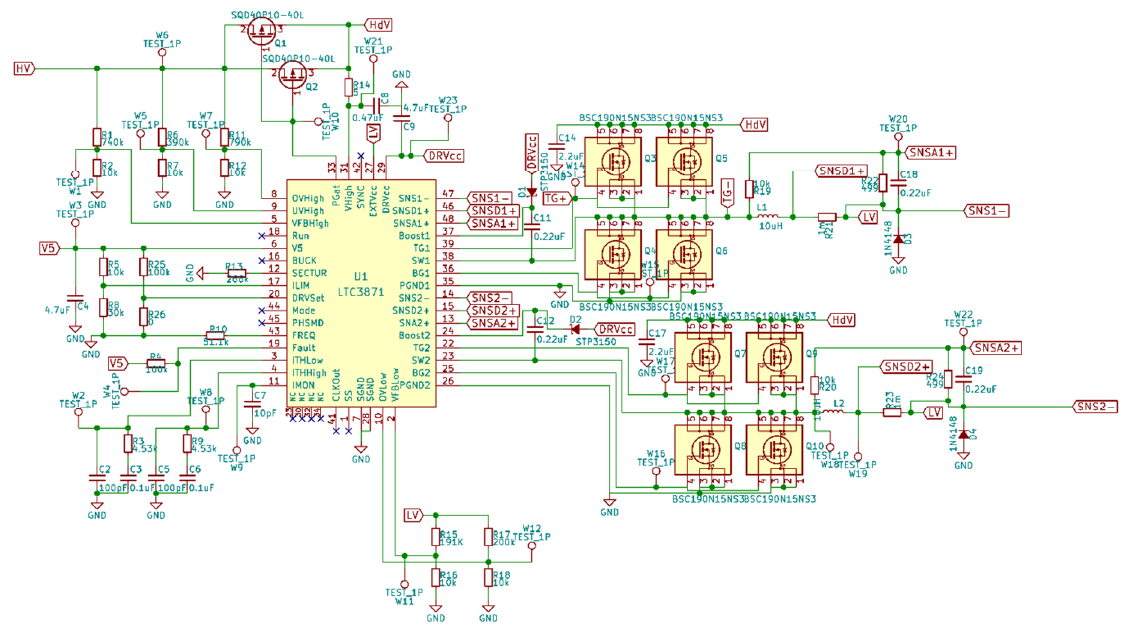
Figure A1. The schematic drawing of the DC-DC converter’s printed circuit board. “HV” labels the high voltage input; “LV” labels the low voltage output.